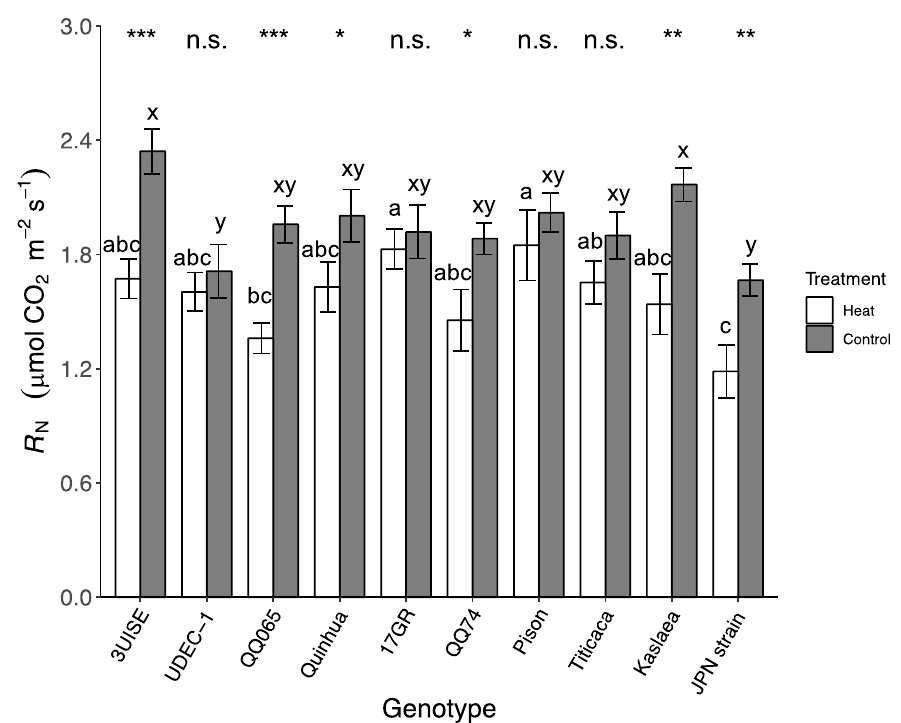
Figure 4. Dark respiration (R N ; μmol CO 2 m −2 s −1 ) of 10 quinoa genotypes exposed to a four-day heat treatment (45 °C/30 °C) and a control treatment (20 °C/14 °C); day and night, respectively. Measurements were taken in full darkness between 21:30 and 23:00. Values are means ± SE ( n = 18–28). Mean comparisons are shown for within genotype (asterisks and n.s.) and within temperature treatment (Heat: a to c; Control: x to y); different letters are significantly different at p < 0.05; *, p < 0.05; **, p < 0.01; ***, p < 0.001; n.s., not significantly different.